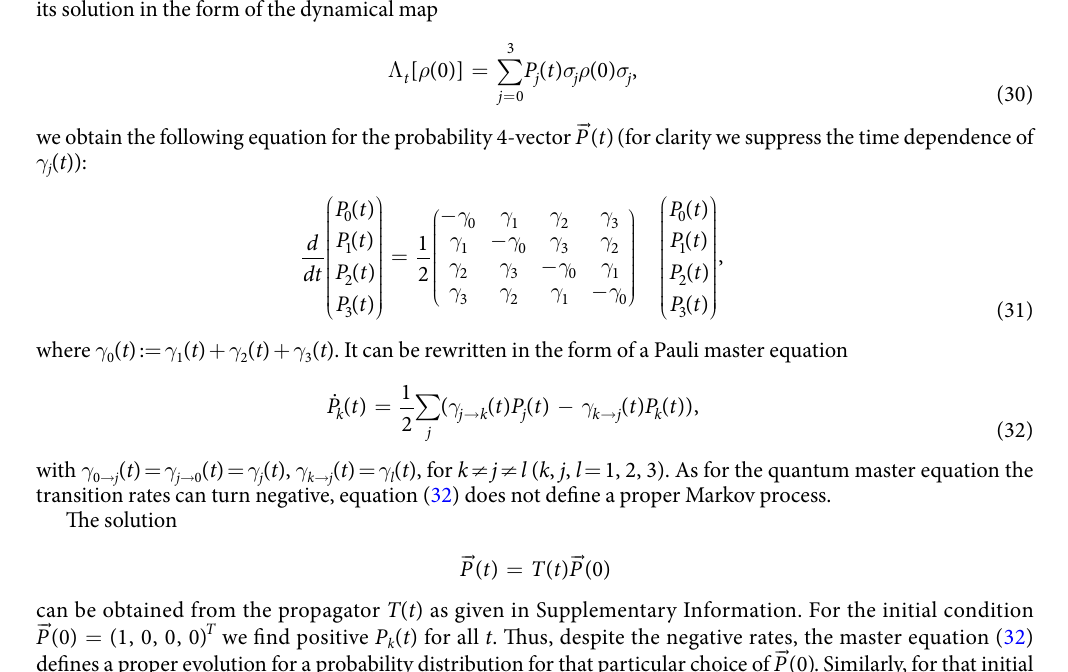
Negative rate classical master equation.